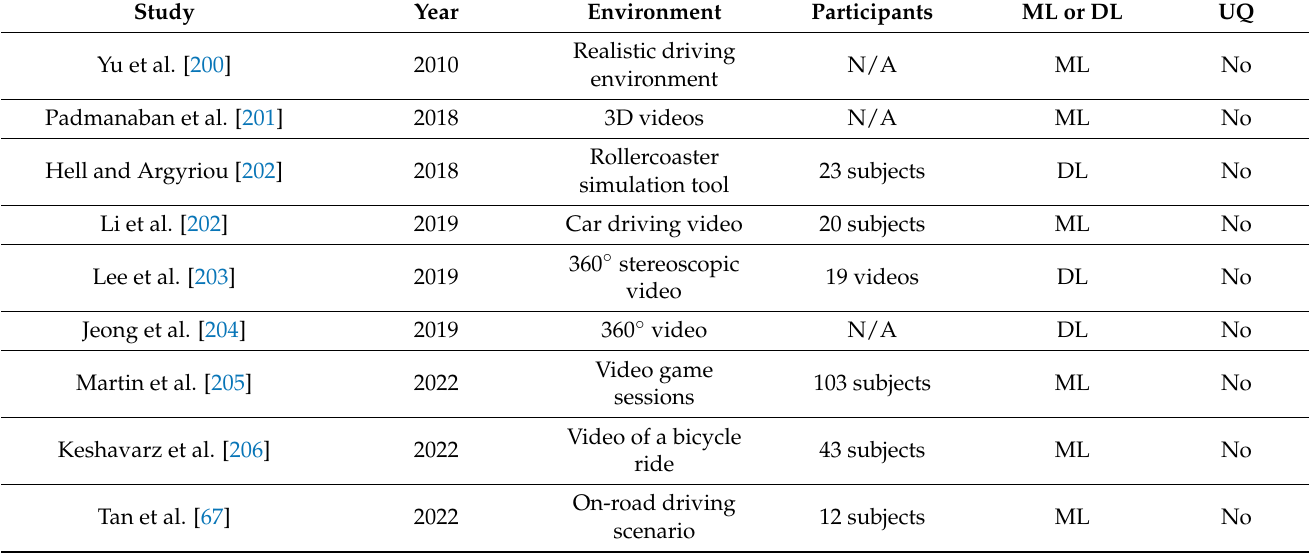
Table 3. Application of ML and DL methods in